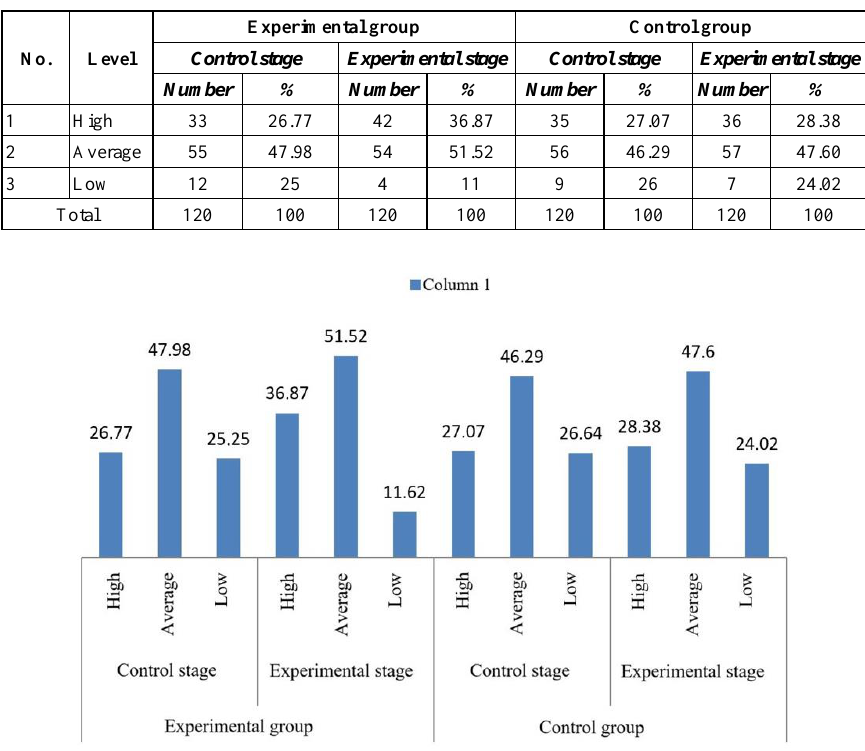
Fig. 4. Distribution of students by communicative skill levels at the control and experiential